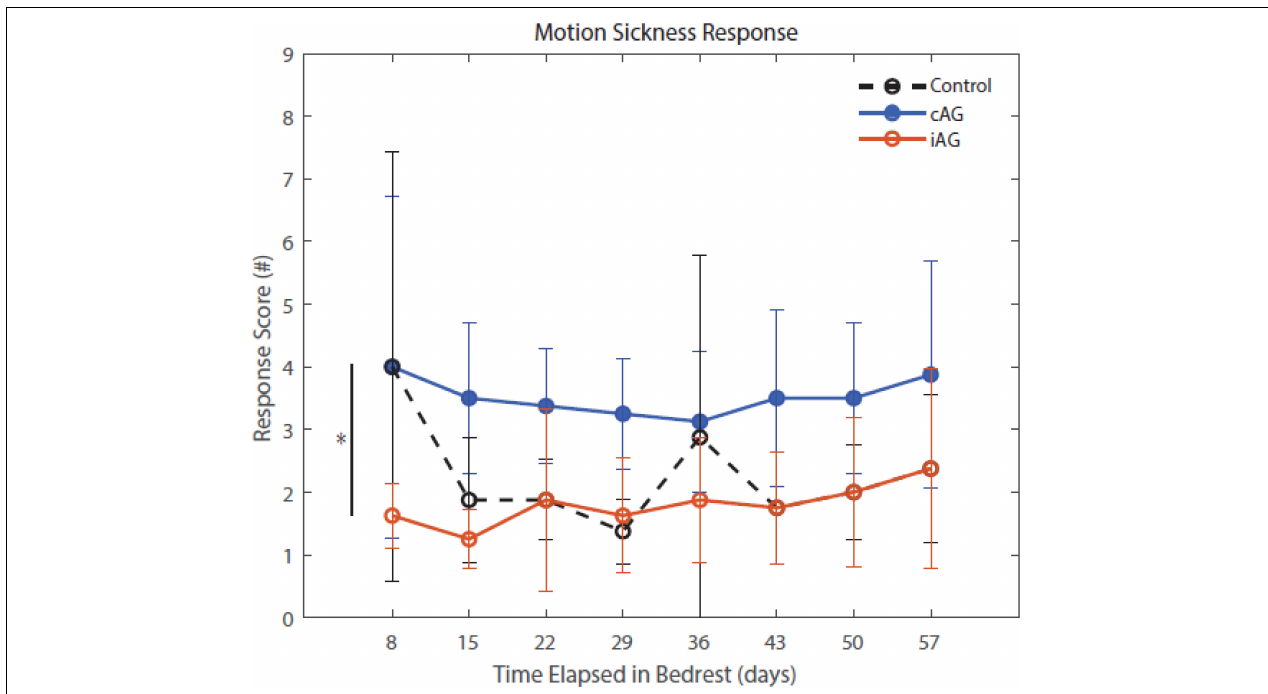
FIGURE 5 | Motion Sickness Response throughout HDBR. Motion sickness response scores indicate a significant group difference between the two AG groups, cAG and iAG, that is maintained throughout the entirety of HDBR ( p = 0.04). This group difference is noted by the ∗ in the figure. The iAG group had less motion sickness than the cAG group. There is also a significant group by HDBR interaction of these two AG groups ( p = 0.032).